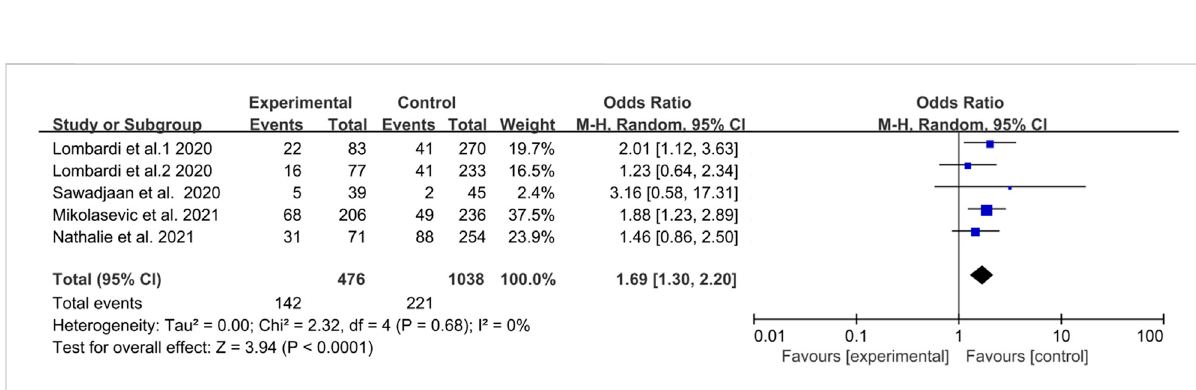
FIGURE 2 Meta-analysis of association between non-alcoholic fatty liver disease and the risk of diabetic retinopathy in diabetes mellitus.